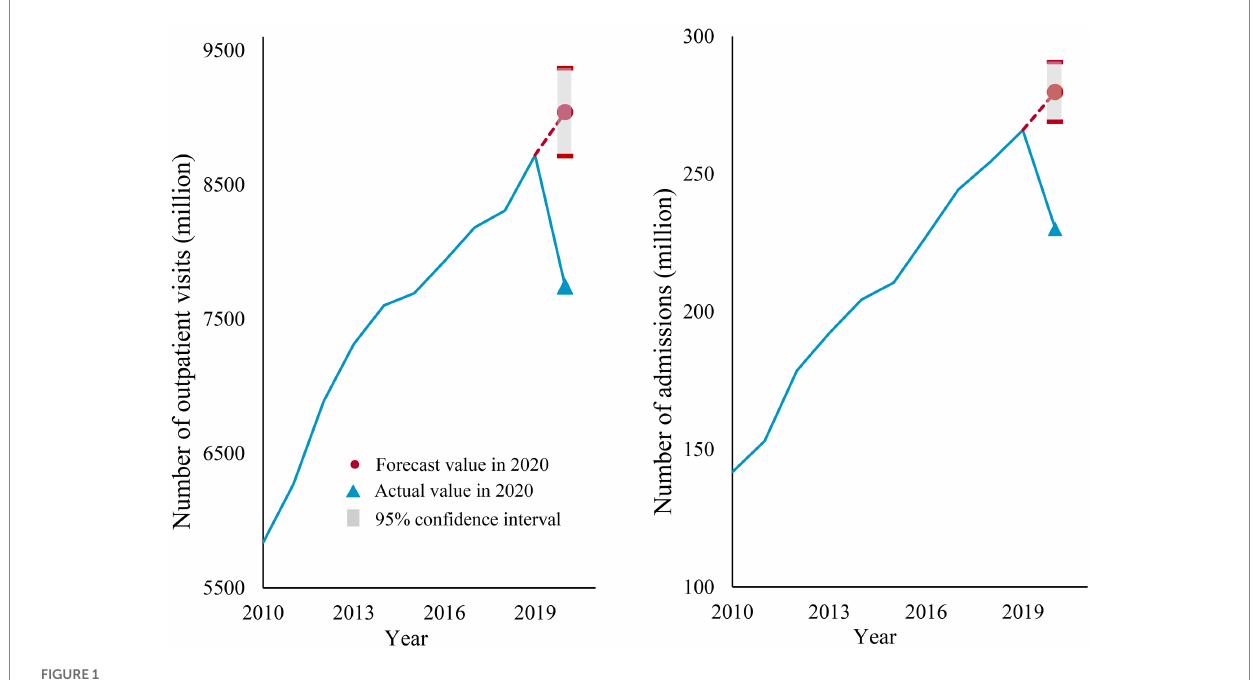
FIGURE 1 Actual and forecast values of overall health service utilization in